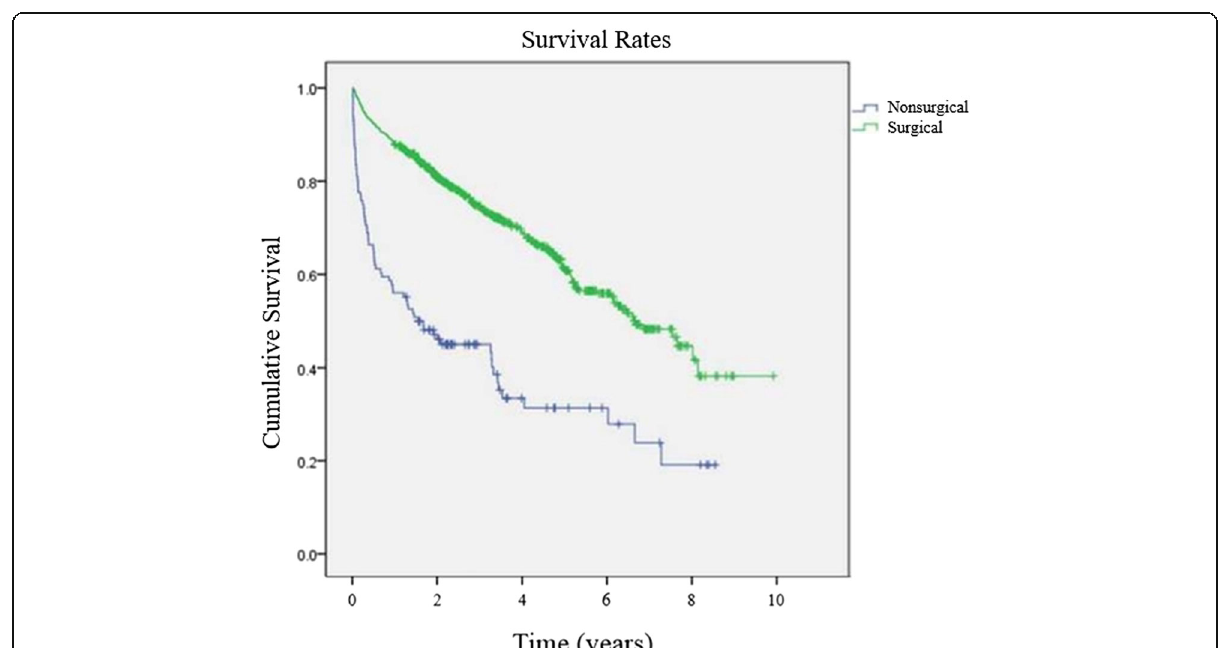
Fig. 1 Kaplan-Meier survival rates between surgical and nonsurgical treatment groups